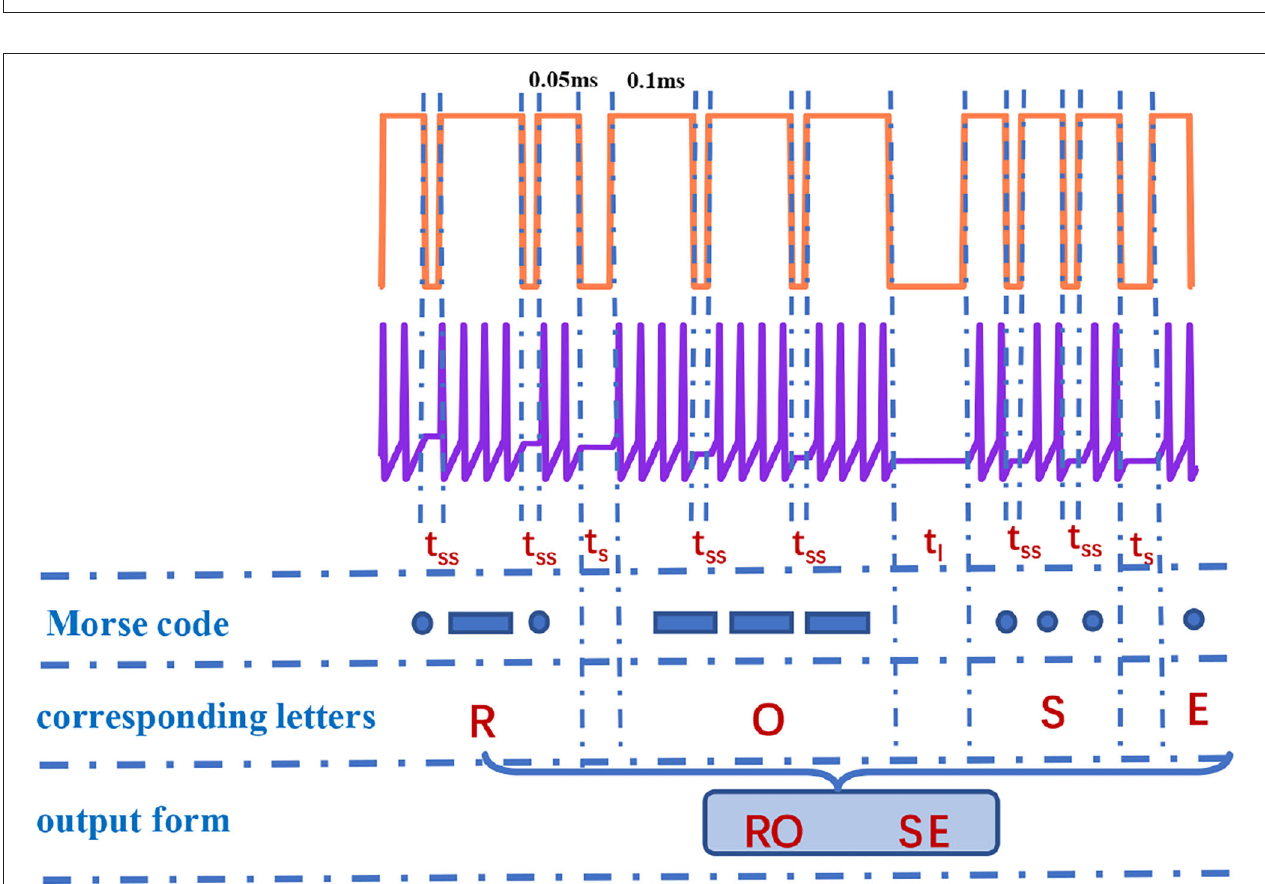
FIGURE 11 | The recognition of “RO” and “SE” in Morse code [the action time of a series of pulses is 1,000 ms (the coral red plot)]. of the Morse code. The long- and short-time intervals ( t l , t s ) spikes in letters “J”, “Q”, and “Y” is 14, and the total number of without spikes indicate the spacing between words and between spikes in letters “A”, “N”, and “S” is 6. The internal-spike interval letters, accordingly ( Figure 11 ). In our simulation, we assume is the length of time between the generated action potentials. It that “RO” and “SE” are two words separated by the long- can be used to identify whether the produced action potential is time interval.And the current pulse interval is 0.02 ms ( t ss ), the a single letter or a word. Therefore, we need to consider the pulse width of narrow pulses is 0.05 ms , the width of wide pulses is time intervals in the simulation ( t ss , t l , and t s ) to recognize the 0.1 ms , the interval between letters is 0.04 ms ( t s ), and the Morse code correctly. The t ss means the internal time interval